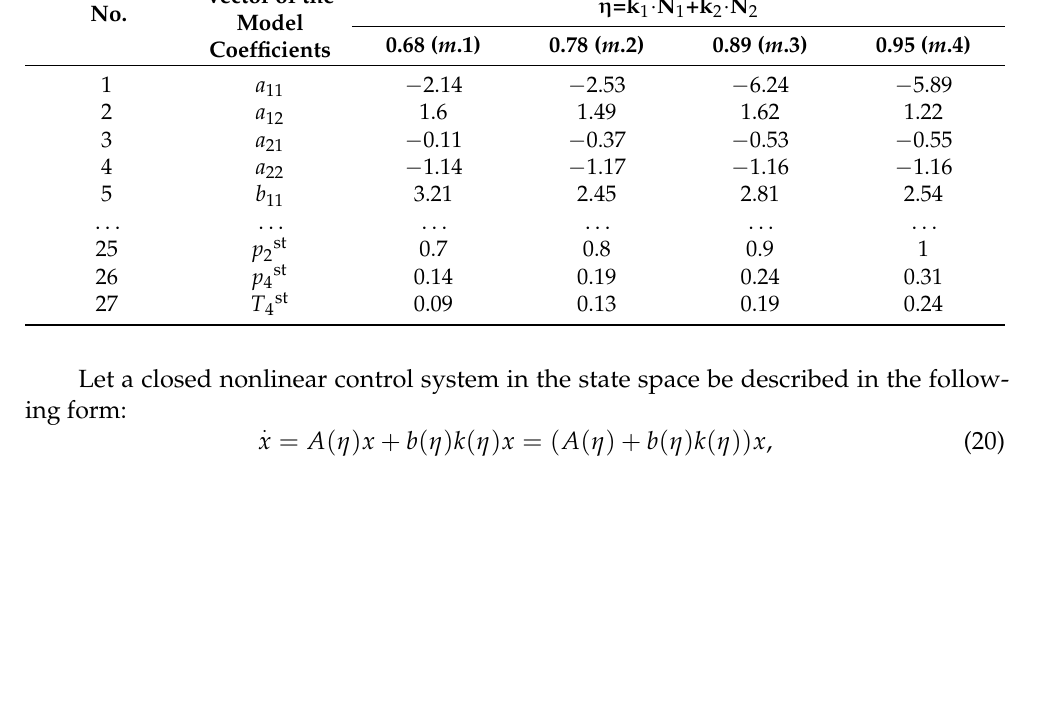
Table 1. The values of the parameters of the dynamic model of the gas turbine engine [13]. Vector of No.